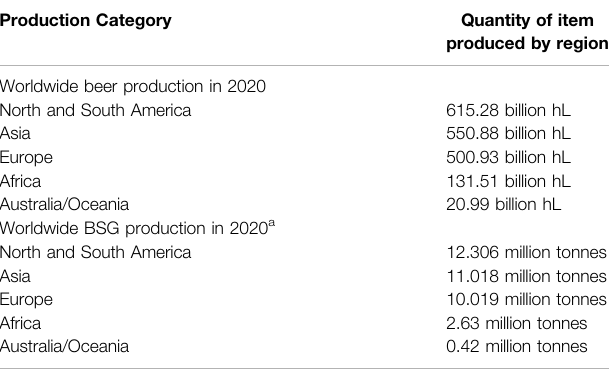
TABLE 1 | Worldwide beer and BSG